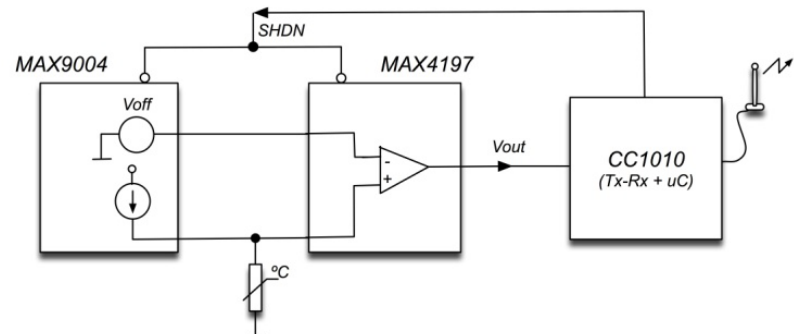
Figure 3. Block diagram of temperature conditioning